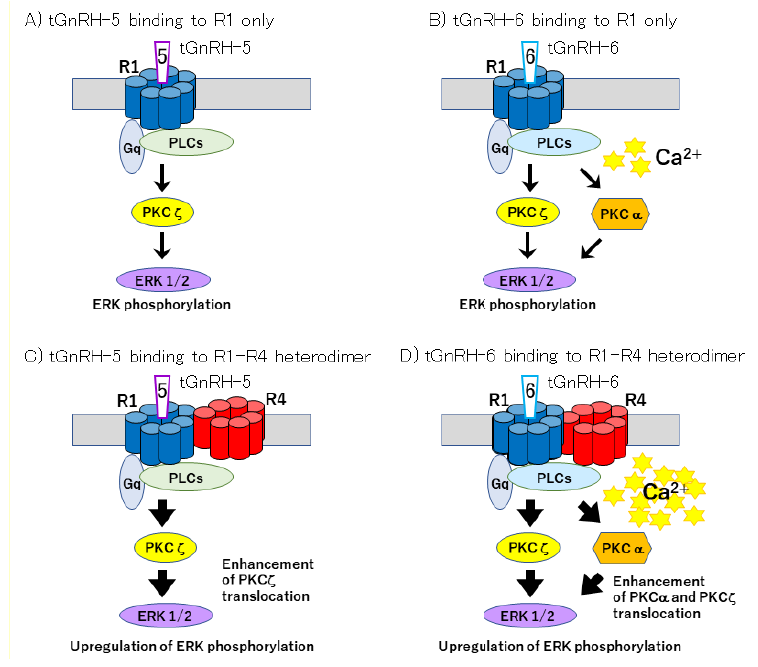
Figure 1. Signaling cascades triggered by the interaction of Ciona gonadotropin-releasing hormones (GnRHs) with the cognate receptor. ( A ) Interaction of tGnRH-5 with Ci-GnRHR-1 (R1) activates a calcium-independent protein kinase C (PKC), PKC ζ , followed by the upregulation of extracellular signal-regulated protein kinase (ERK) phosphorylation. ( B ) Interaction of tGnRH-6 with R1 activates PKCζ and a calcium - dependent PKC, PKC α, leading to the upregulation of ERK phosphorylation. Both signaling pathways are potentiated via the heterodimerization of Ci-GnRHR-1 with a species-specific orphan GPCR paralog, Ci-GnRHR-4 ( C , D ).